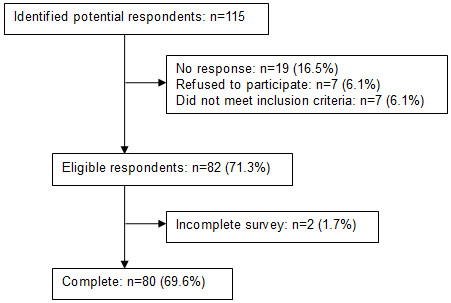
Study recruitment
.